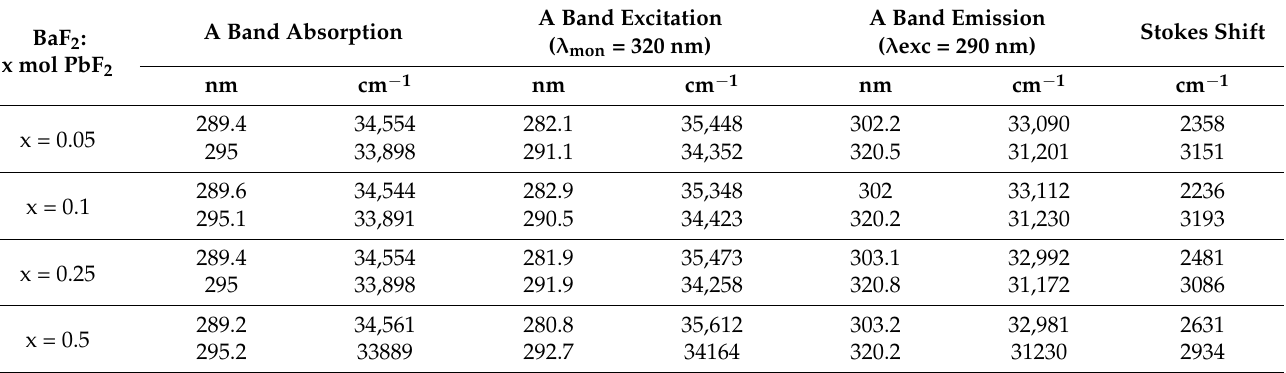
Table 5. The components of the optical absorption A band, the excitation A band components monitored for the 320 nm emission peak, and the UV emission under excitation in the A band (290 nm) 1